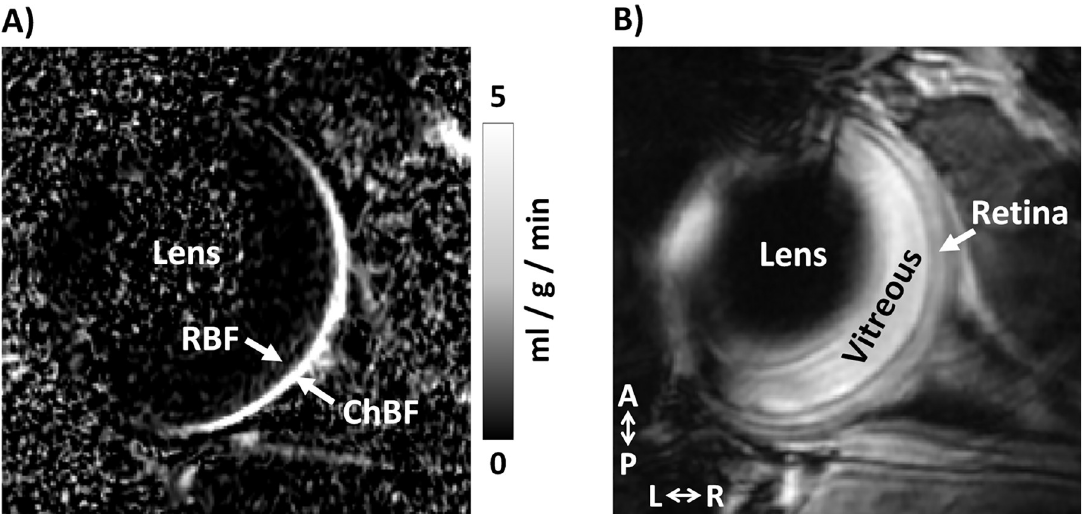
Fig 2. Blood flow MRI images of a mouse eye. (A) A blood flow map and (B) the corresponding anatomical EPI image. Retinal blood flow (RBF) and choroidal blood flow (ChBF) are indicated. A: anterior, P: posterior, L: left, R: right. The blood flow map is scaled from 0 to 5 ml/g/min.